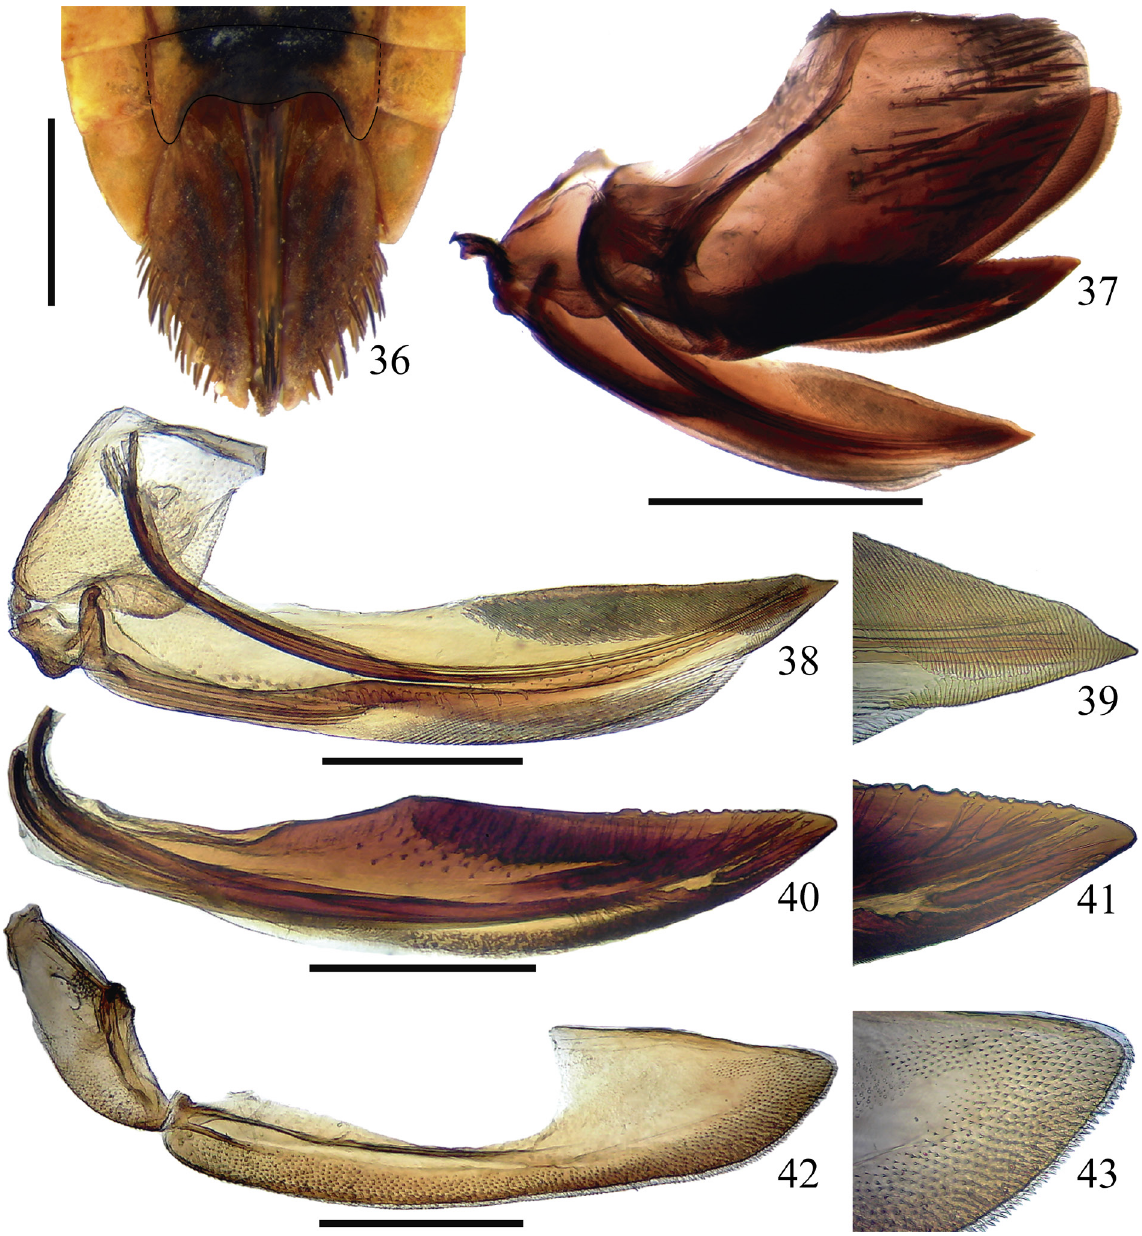
Figs 36–43. Rectapona nigrifascia gen. et sp. nov., paratype, ♀ (DZUP 215372), terminalia. 36 . Sternite VII and pygofer, ventral view. 37 . Pygofer and valvulae, lateral view. 38 . First valvifer and first valvula, lateral view. 39 . Apex of first valvula, lateral view. 40 . Second valvula, lateral view. 41 . Apex of second valvula, lateral view. 42 . Second valvifer and gonoplac, lateral view. 43 . Apex of gonoplac. Scale bars: 36–37 = 1.0 mm; 38, 40, 42 = 0.5 mm; 39, 41, 43 = not to